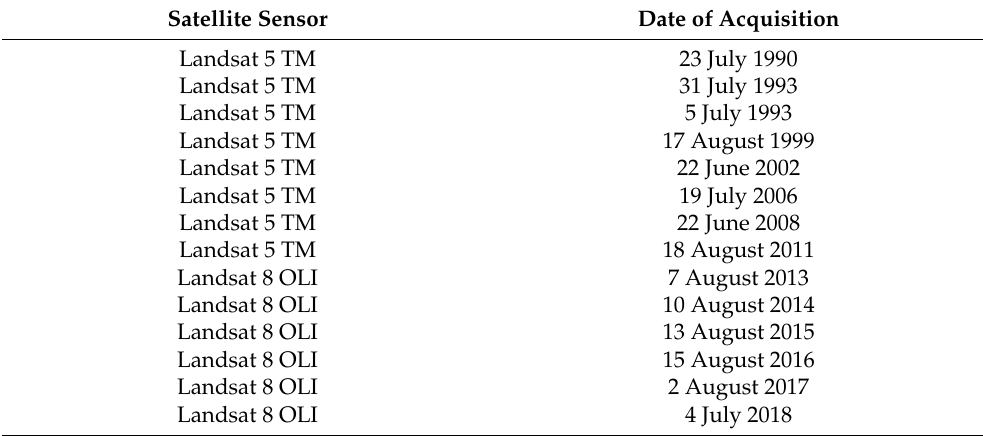
Table 2. Landsat 5 TM and Landsat 8 OLI images used in the time series analysis (Worldwide Reference System—WRS—Path/Row